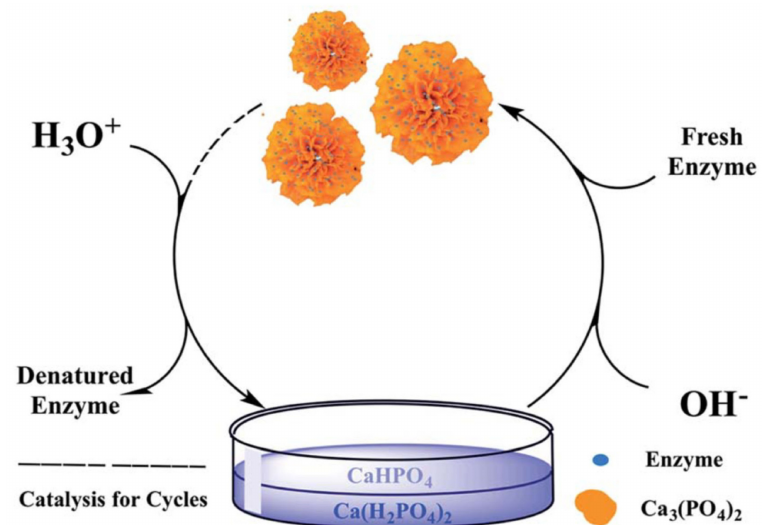
Figure 7. Dual cycle process for enzyme immobilization. Reprinted from [37] with permission from the Royal Society of Chemistry under the Creative Commons Attribution 3.0 Unported